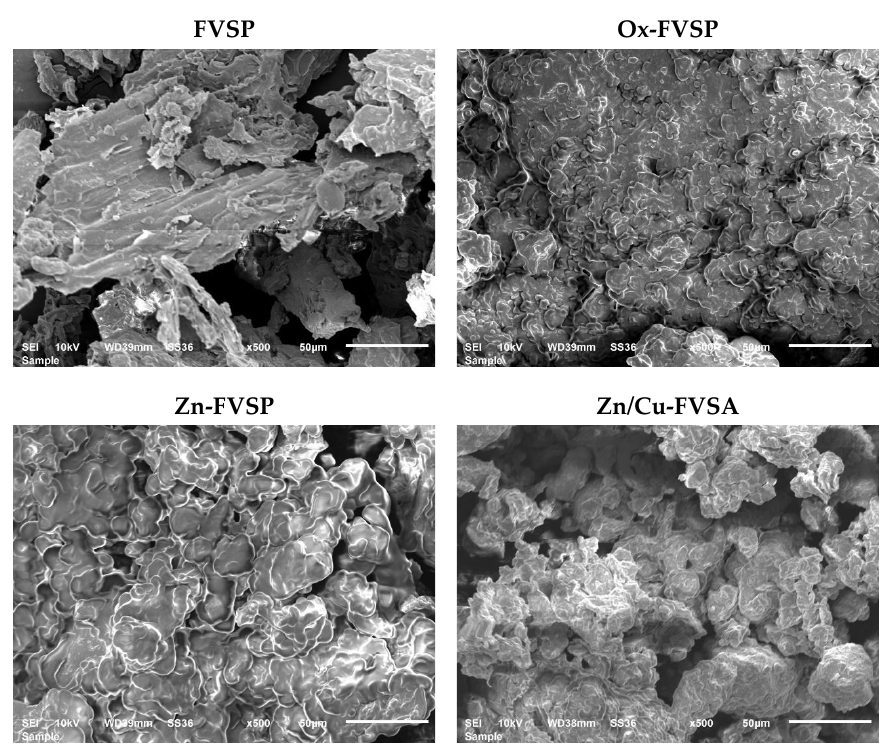
Figure 1. SEM micrographs of the adsorbent used in the CR adsorption.